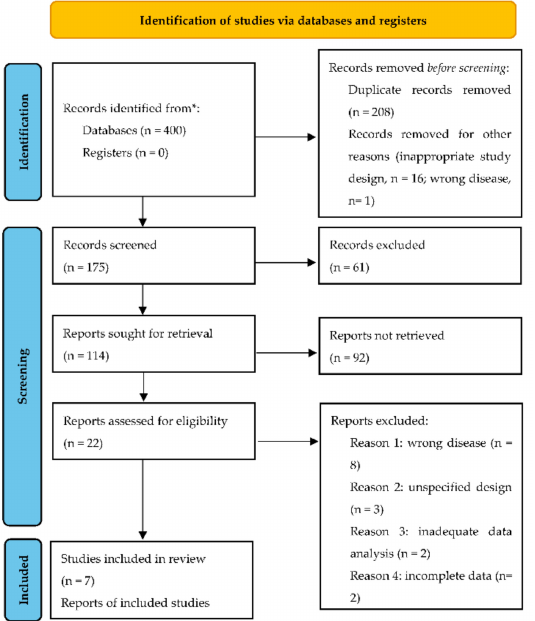
Figure 1. Flow diagram of search and selection of studies. * markup of data